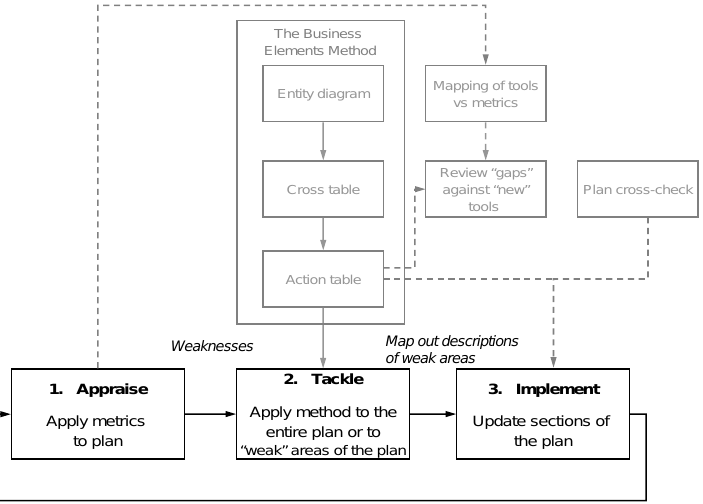
Fig. 1. Diagram of the FIM FRAME